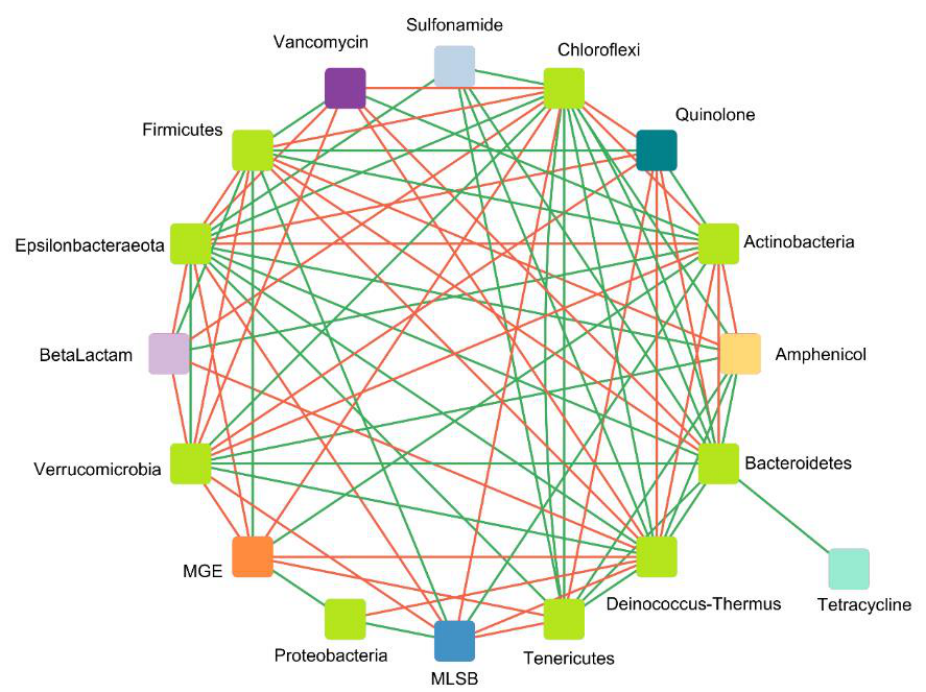
Figure 10. Microbial taxon and gene class interaction network analysis as a ’circular layout‘ based on the co-occurrence of ARG groups and microbial taxa at phylum level. A connection shows a significant correlation based on Spearman’s rank analysis (|r|/.0.7, p < 0.05). The green and red edges indicate positive and negative correlations between ARGs and taxa, respectively.